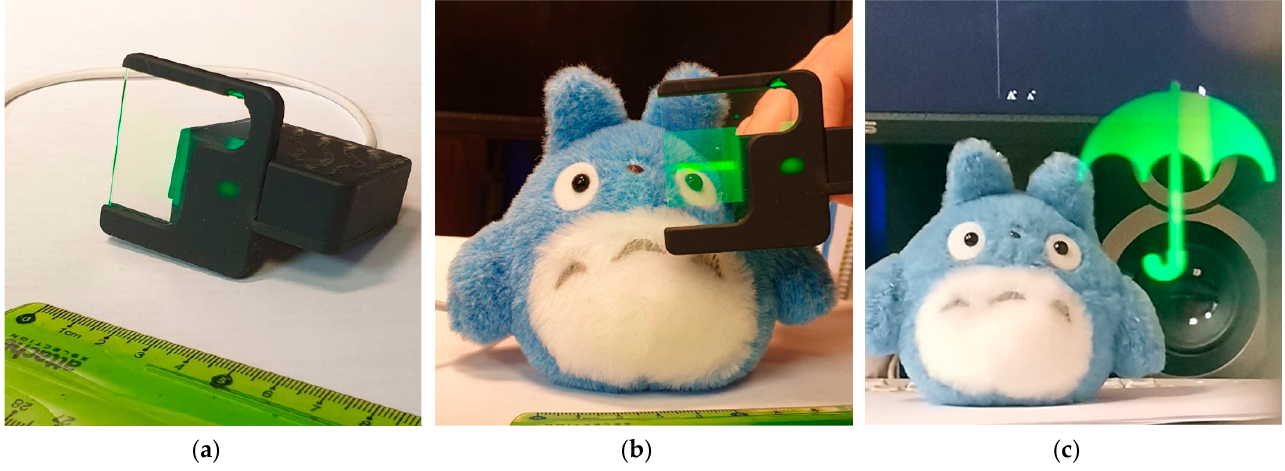
Figure 6. Prototype: ( a ) appearance; ( b ) illustration of the waveguide transparency; ( c ) illustration of augmented information added to the real view.